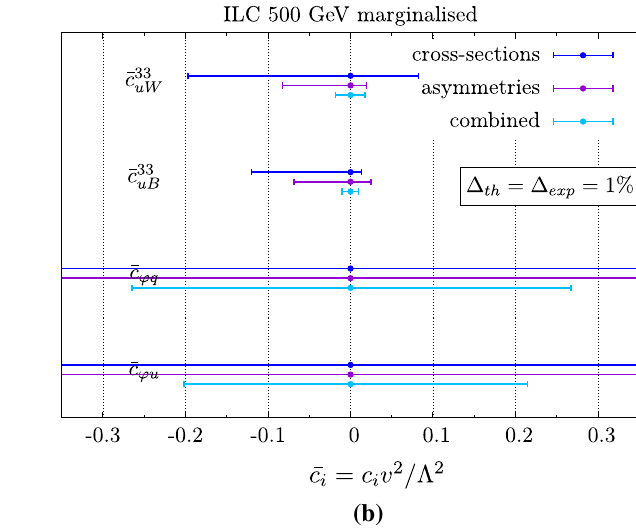
Fig. 6 95%confidencerangesfortheoperatorsweconsiderhere,from the 500 GeV ILC, assuming 1% theoretical and experimental uncertain- ties,byfittingtocross-sections,asymmetries,andthecombination,with